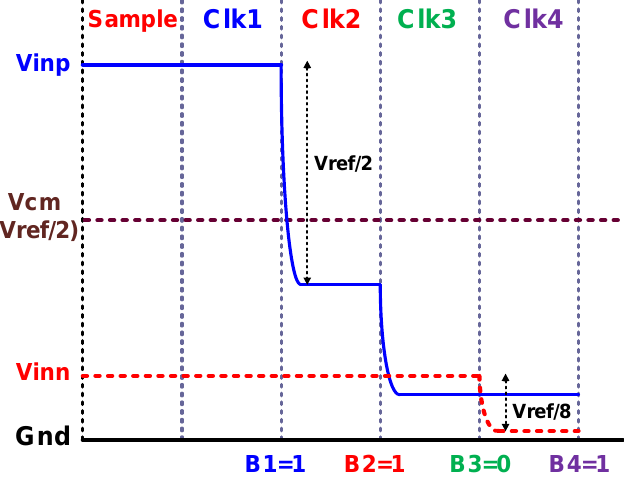
Figure 4. Waveform of the adopted monotonic switching procedure.